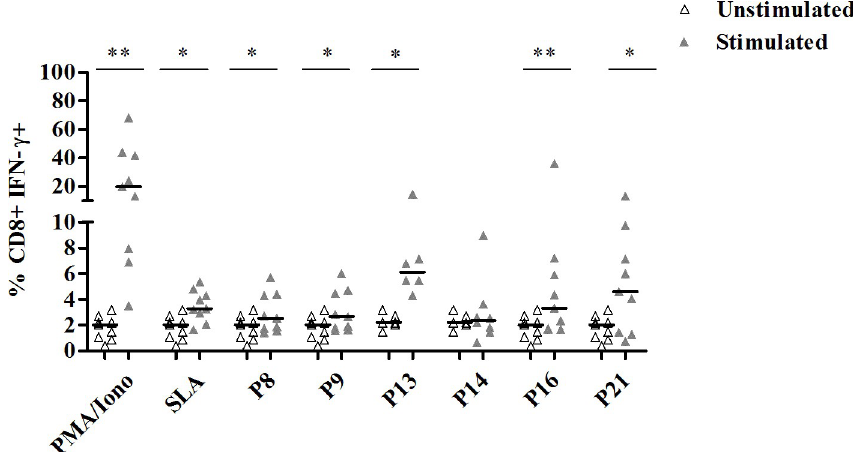
Fig 9. Percentages of CD8+ T cells producing IFN- γ in response to selected multi-epitope peptide pools. PBMC from cured CL subjects (N = 9), previously stimulated with selected peptide pools (1 μ M/peptide) for 10 days, were re- stimulated overnight with the same peptide pools (1 μ M/peptide) and with anti-CD49d/anti-CD28 antibodies (1 μ g/ ml). For intracellular IFN- γ detection, cells were treated with Golgistop for 6 h of culture, fixed and permeabilized using BD Cytoperm/cytofix kit. Data were analyzed by FlowJo software. PBMC stimulated with PMA (50 ng/ml)/ Ionomicyn (10 –6 M) for 6 h or SLA (10 μ g/ml) for 5 days, were used as positive control. Results represent the frequency of CD8+ IFN- γ + T cell populations. Horizontal bars represent median values. Statistical significance was assigned to a value of p < 0,05 ( � p < 0.05, �� p < 0.01).